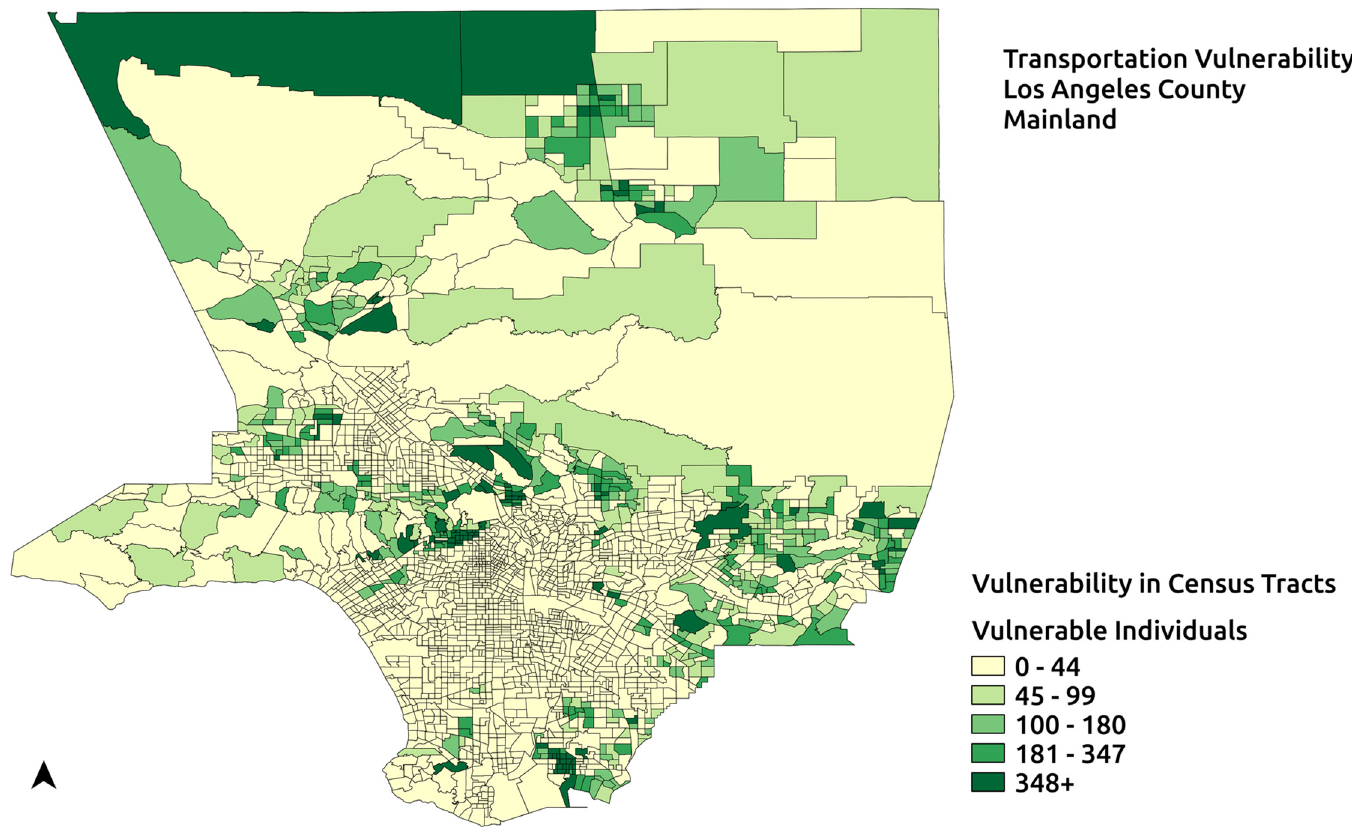
Fig 7. Transportation vulnerable population not served by potential response plan. Vulnerable population after including public transportation and a maximum walking distance of 2